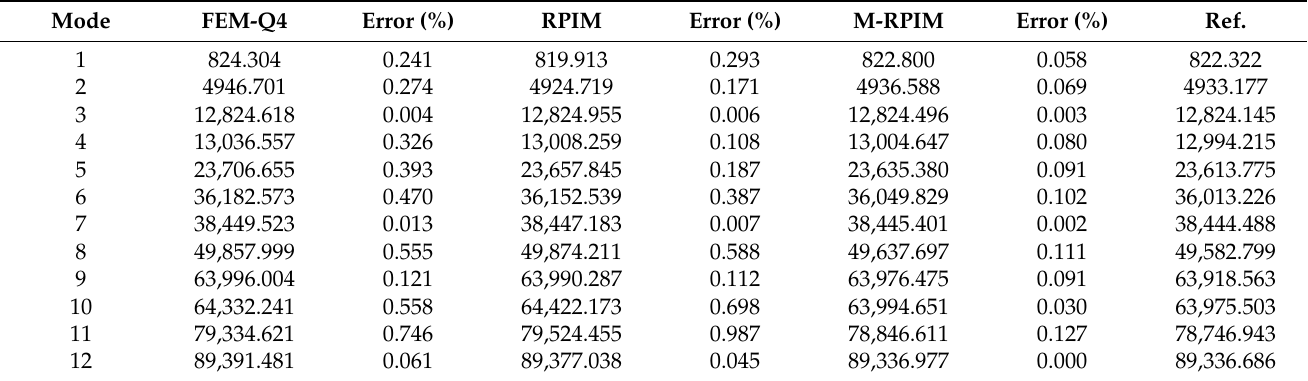
Table 2. The first twelve natural frequency solutions from the three numerical methods using the node arrangement pattern with average nodal space h = 1 mm.